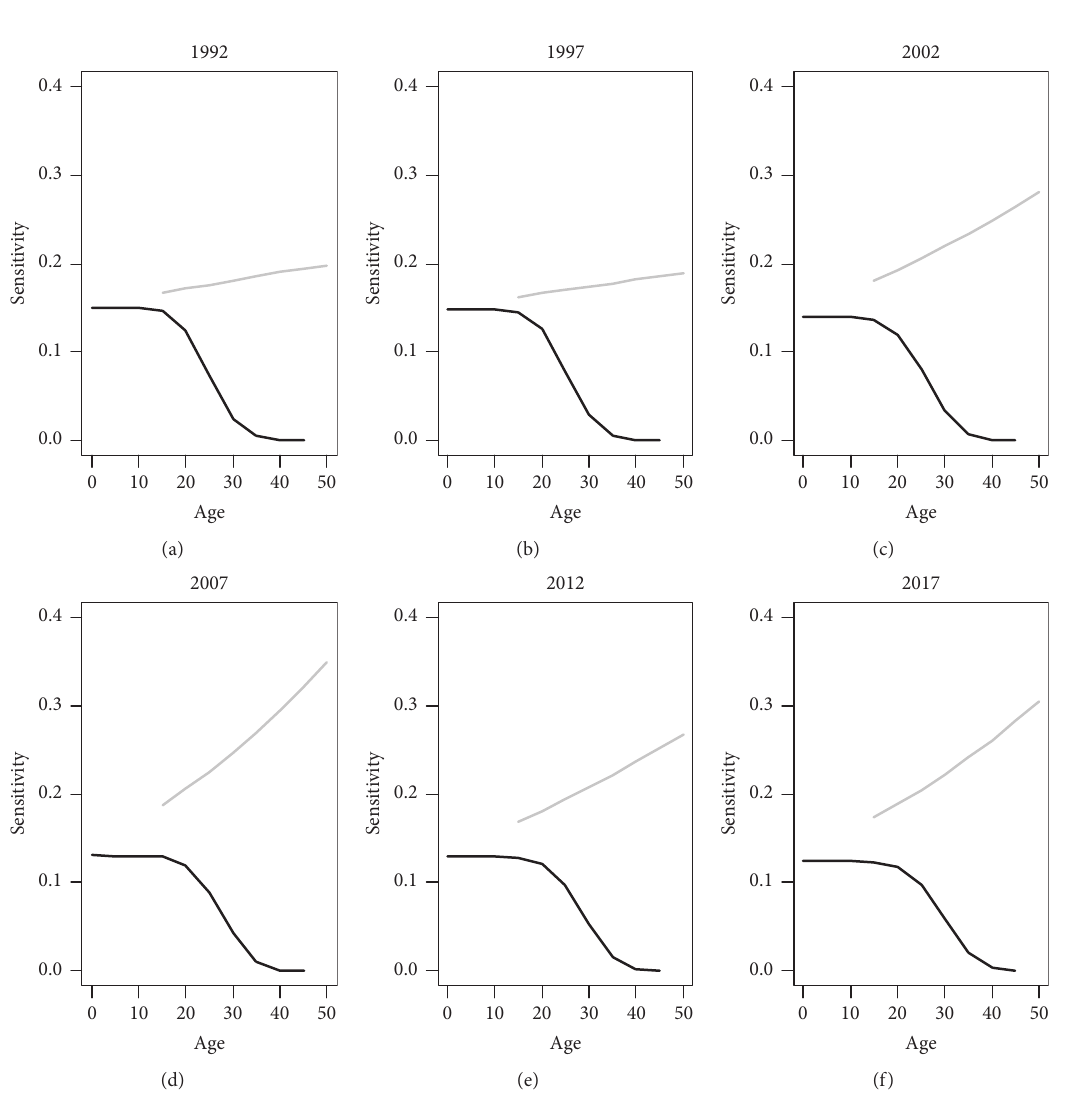
Figure 6: Sensitivities to age-specific survival in black and fertility in